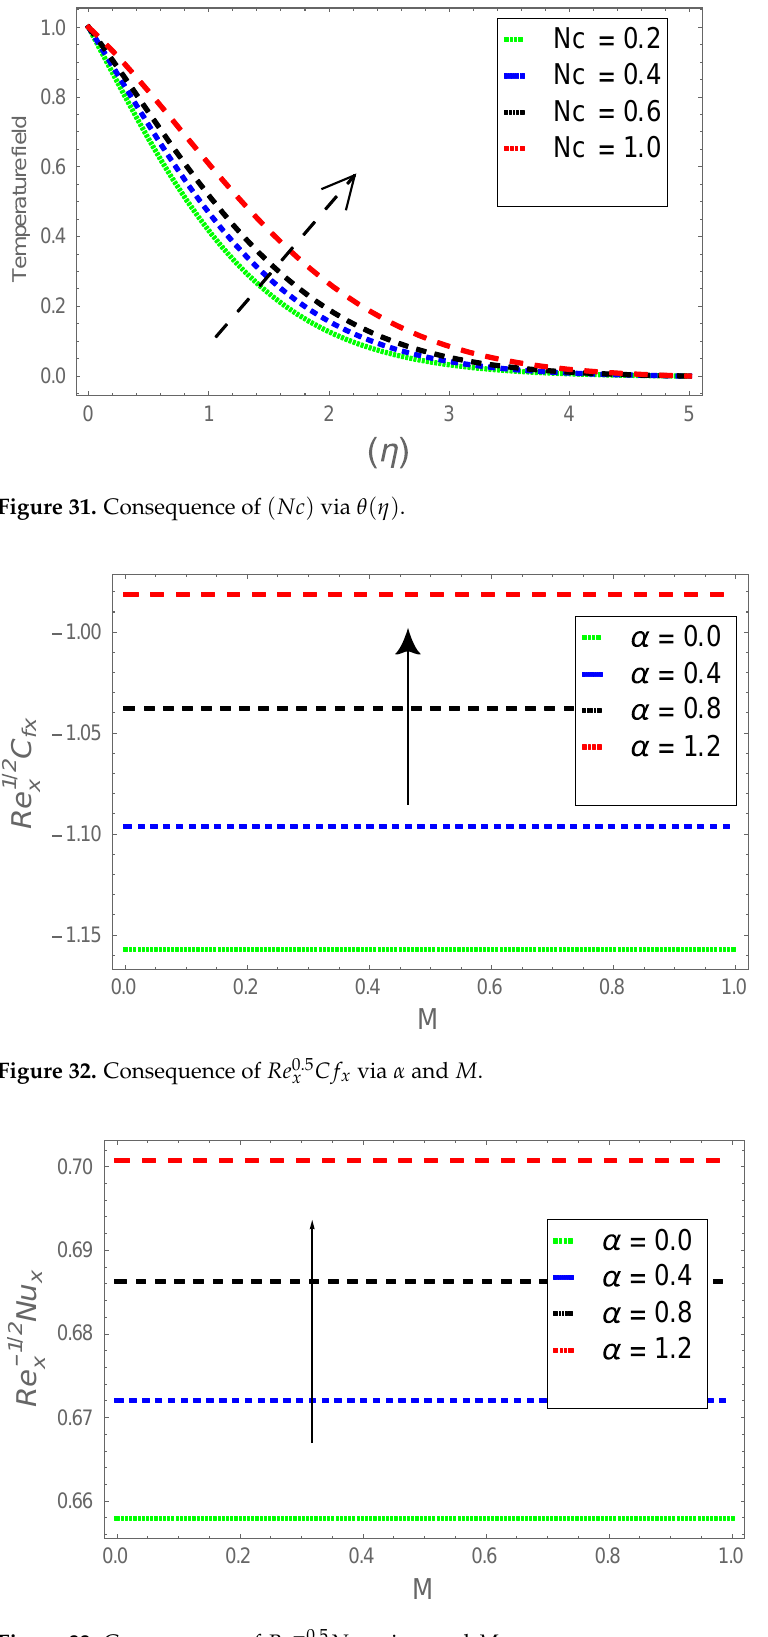
Figure 33. Consequence of Re − 0.5 x Nu x via α and M